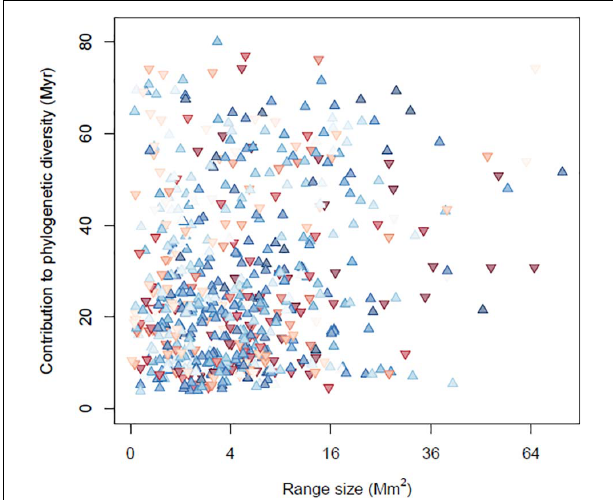
FIGURE 4 | Occupancy trends for each bird species, plotted as a function of its geographic range size and phylogenetic distinctness. Blue upward-pointing triangles indicate species that are occurring at more sites through time, while red downward-pointing triangles indicate declining species, with the darkness indicating the strength of the